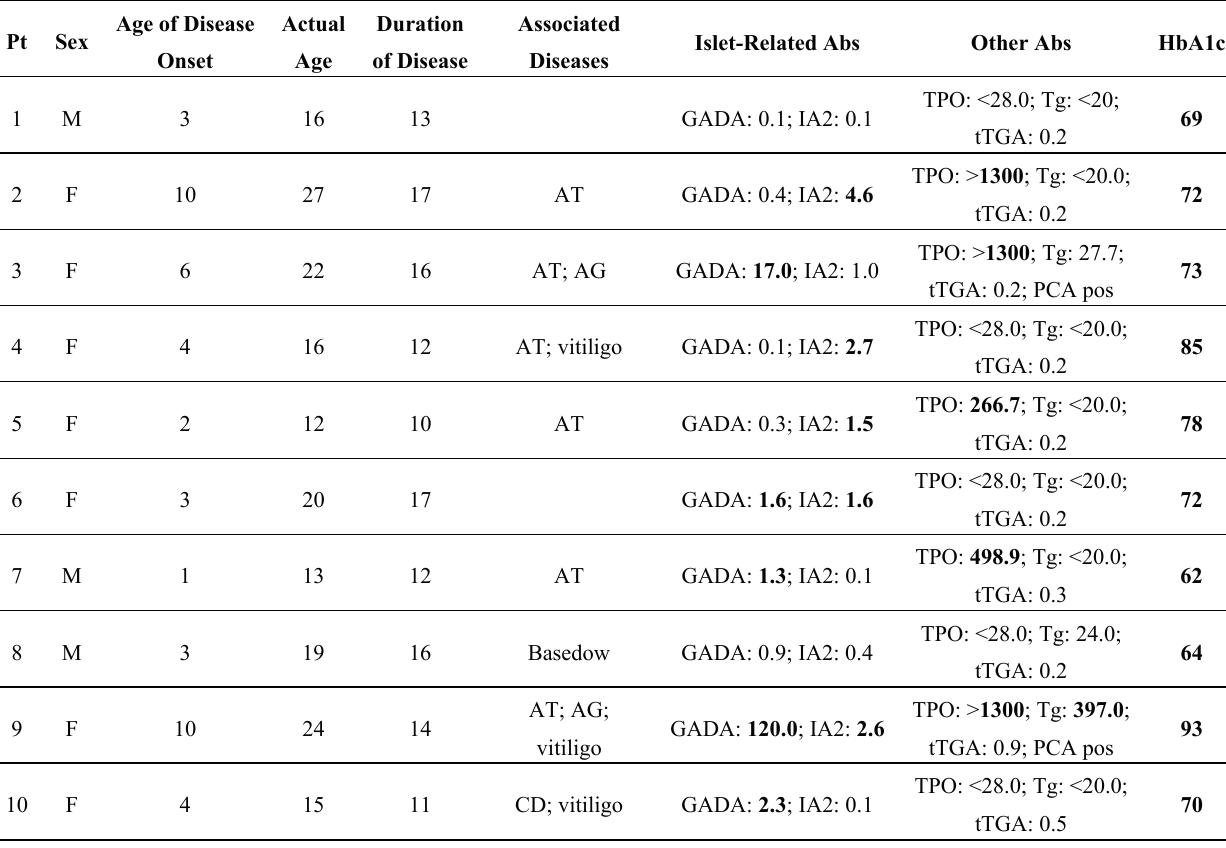
Table 1. Demographic, clinical, laboratory and metabolic characteristics of the long-standing T1D patients recruited for the study.